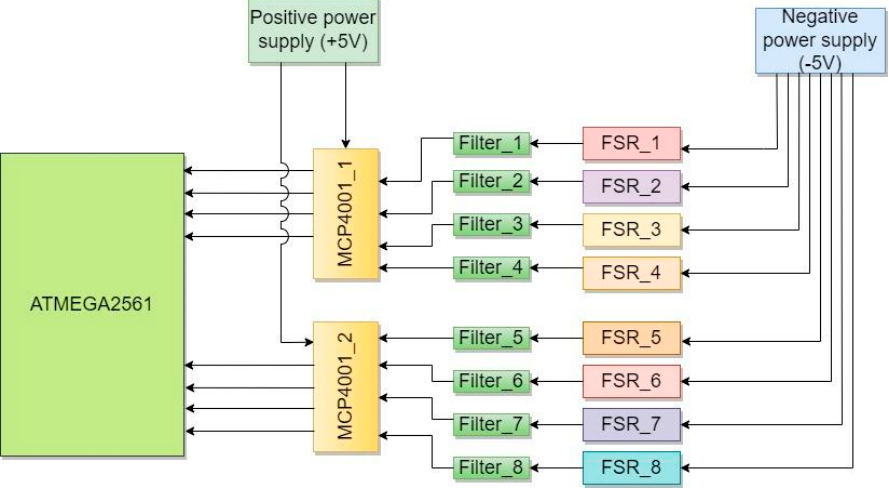
Figure 8 . The hardware diagram. Figure 8. The hardware